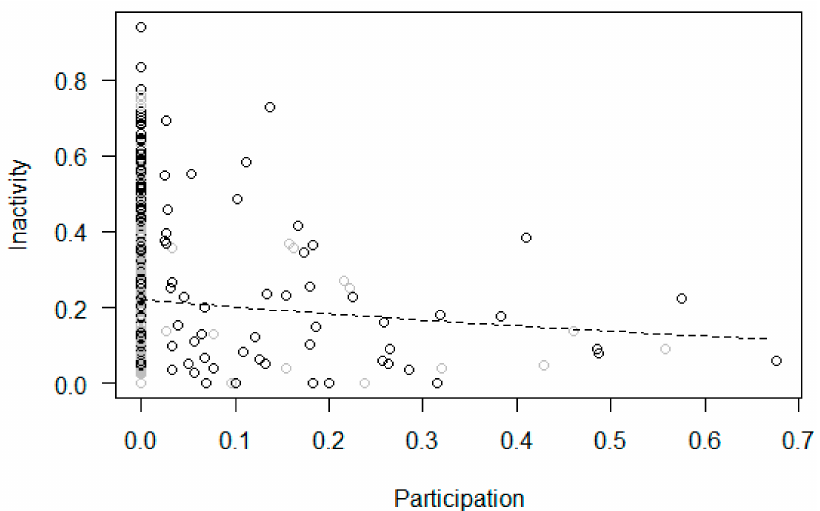
Figure 7. Inactivity (i.e., proportion of scans that an individual was inactive, out of the total number of scans in which the subject was visible) as a function of participation (i.e., proportion of scans an individual interacted with the enrichment device in an enrichment session) during the treatment phase. Circles represent individual responses in each enrichment session in the morning (in black) and afternoon (in grey). The dashed line represents the fitted model, which is like Model 4b but unconditional on all the other predictors that were standardized.